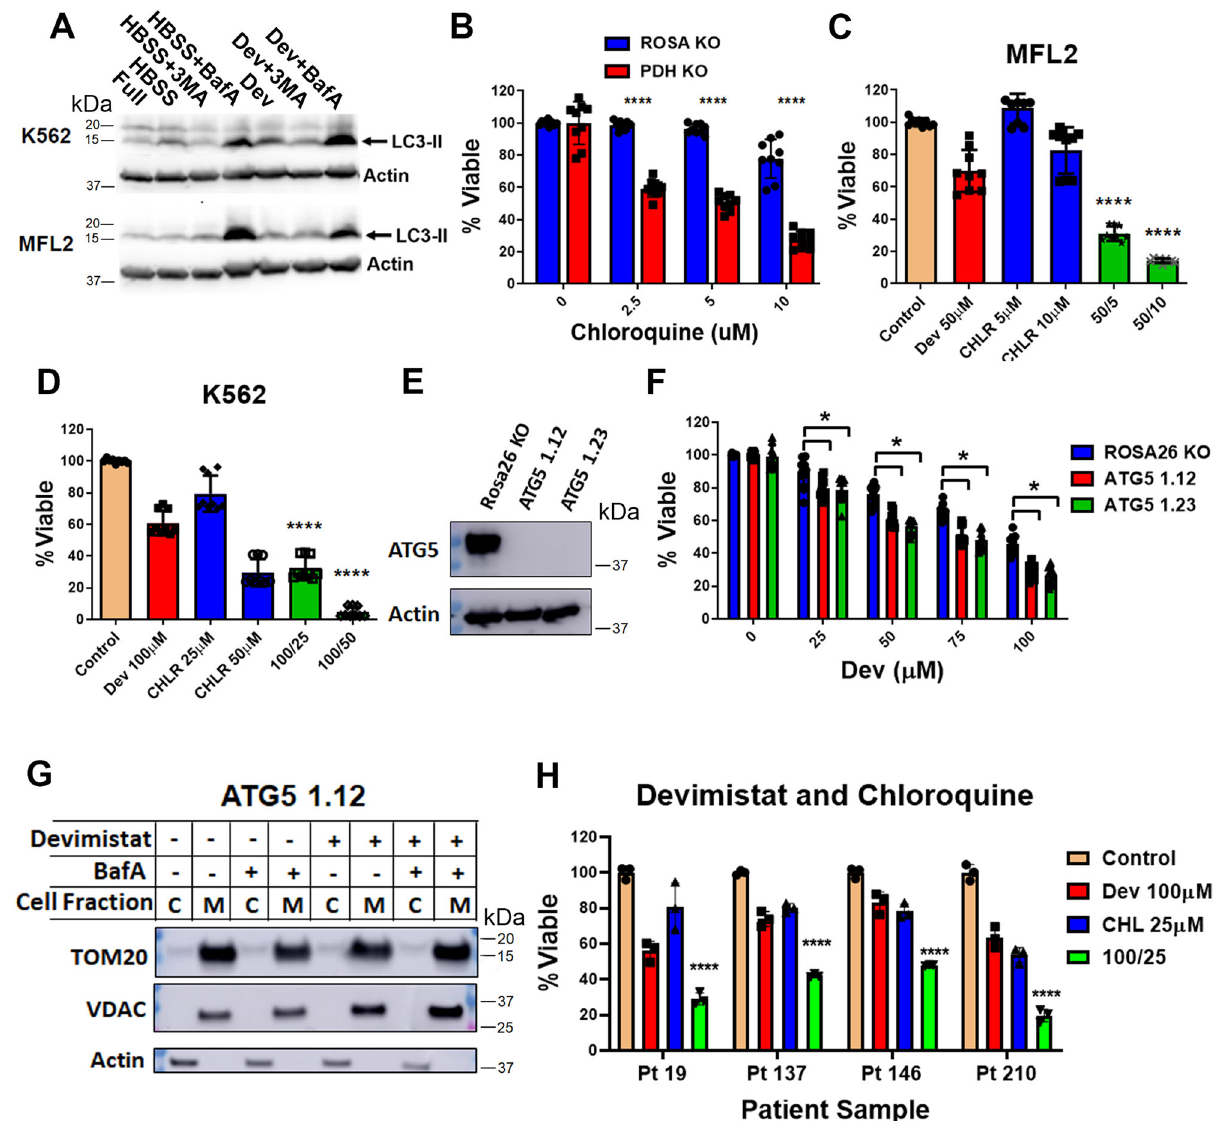
Fig. 5 Devimistat and mitophagy. A Western blot for the autophagy protein LC3B-II (LC3-II). K562 or MFL2 cells were incubated for 4 h in normal media (Full) or Hank ’ s balanced salt solution (HBSS) as negative and positive controls or in normal media with devimistat (Dev). Cells were lysed and blotted for LC3B-II. 3MA 3-methyladenine, BafA Ba fi lomycin A. B Viability assay. Pdha1-deleted or Rosa control cells were treated with the indicated amount of chloroquine for 72 h and viability assessed. C , D Viability assay. K562 or MFL2 cells were incubated with devimistat (CPI), chloroquine (CHLR), or both at the indicated µ M concentrations for 72 h and viability assessed. E Western blot. MFL2 cells expressing Cas9 were infected with sgRNAs targeting Atg5 or the safe harbor locus Rosa26 . Clonal isolates were obtained by serial dilution and blotted for Atg5. Actin is used as a loading control. F Viability assays. Clones from ( E ) were incubated in the indicated concentrations of devimistat (CPI) for 72 h and viability assessed. G Western blot for Vdac1 and Tom20. Atg5 KO cells were treated with vehicle or 100 µ M devimistat as indicated for 24 h, lysed and cytosolic and mitochondrial fractions blotted for the indicated protein. Actin was used as a localization and loading control. H Apoptosis assay. Primary patient sample-derived AML cells were placed in culture and treated as indicated for 72 h. Following treatment cells were stained with annexin V and PI and analyzed by fl ow cytometry. Each treatment was done in triplicate. For all viability assays, a mean of three independent experiments each done in triplicate are shown. Means compared by two-way ANOVA